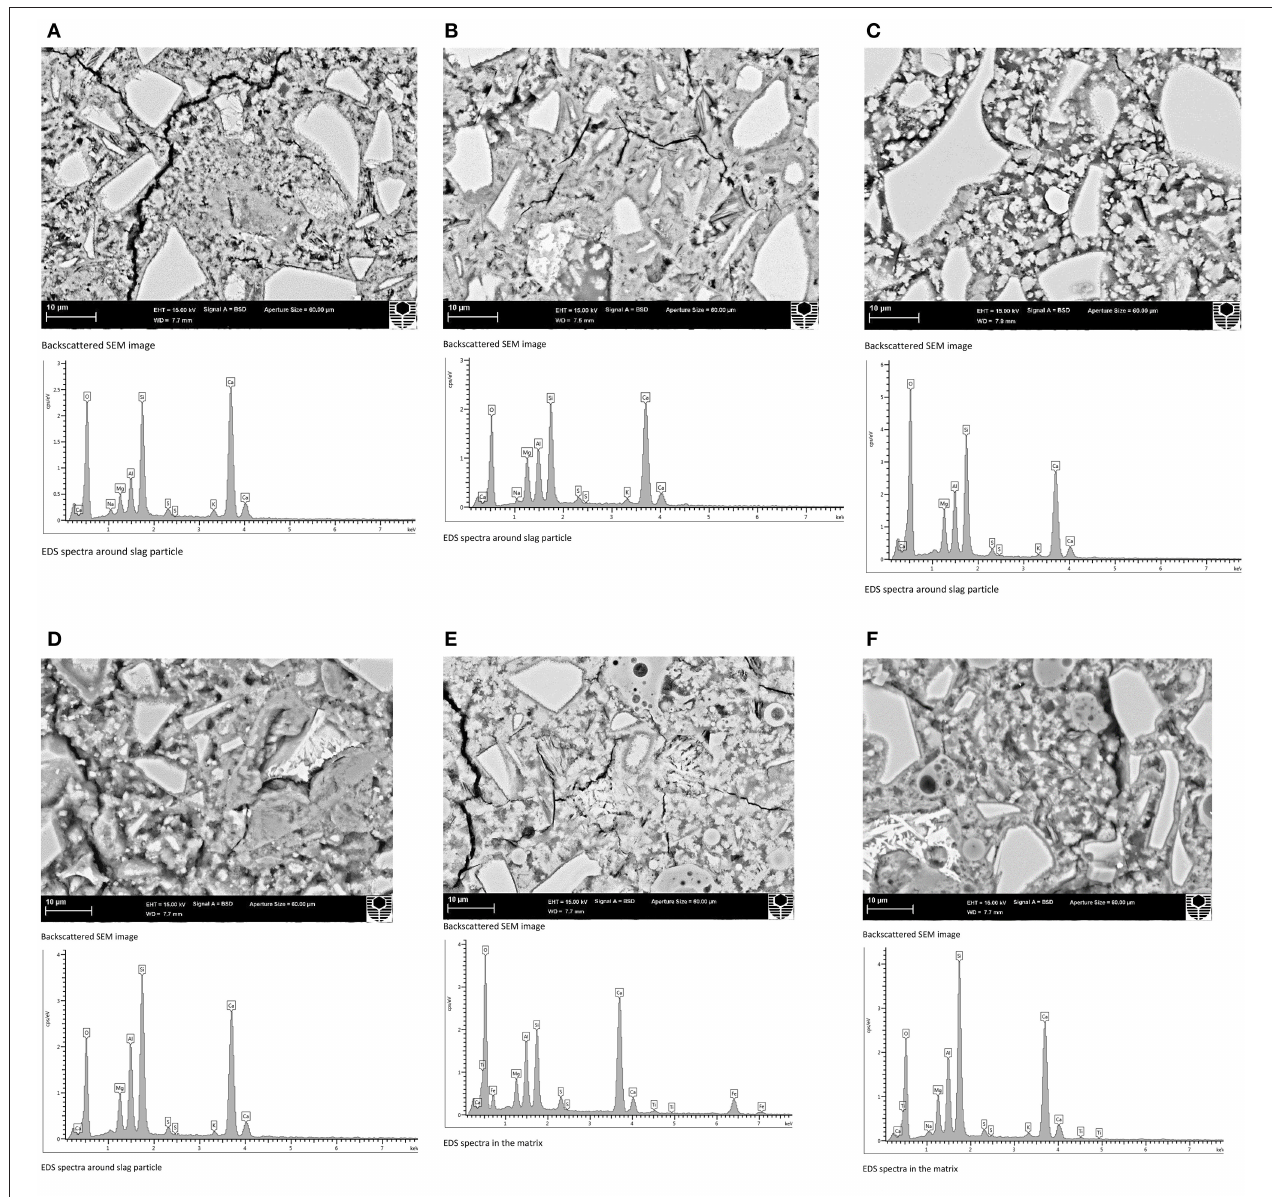
FIGURE 8 | Backscattered scanning electron microscopic (SEM) images and EDS spectra of HVS and HVSFA pastes with and without nano alumina. (A) 70BFS paste. (B) 69BFS+1NA paste. (C) 80BFS paste. (D) 77BFS+3NA paste. (E) 49BFS21FA paste. (F) 48BFS21FA+1NA